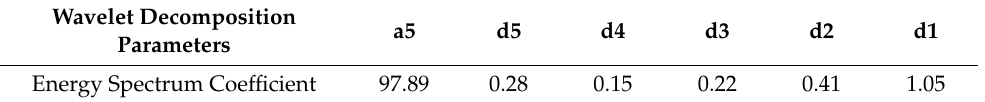
Table 4. Energy spectrum coefficient table of noise signal S3 of Caihong Bridge. Wavelet